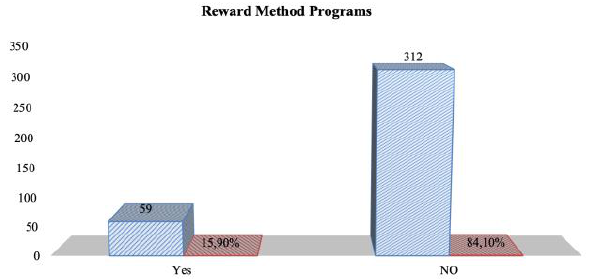
Figure 3: Reward Method Programs; Source: Survey Data (2021)